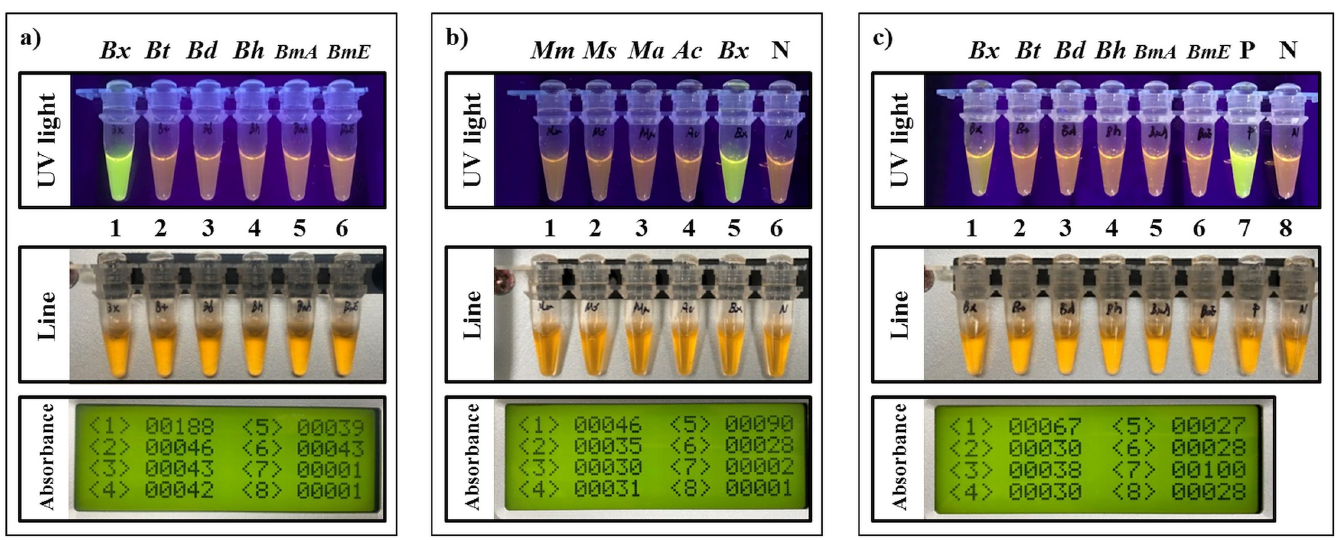
Fig 4. Three types of specificity tests of the RPA assay for B . xylophilus . a) The specificity test of the RPA assay using 6 ng of pure gDNA from B . xylophilus ( Bx ) and five Bursaphelenchus spp.: B . thailandae ( Bt ), B . doui ( Bd ), B . hylobianum ( Bh ), B . mucronatus Asia type ( BmA ), and B . mucronatus Europe type ( BmE ) which have strong genetic relationships with B . xylophilus . b) The specificity test of the RPA assay on organisms: Matsucoccus matsumurae ( Mm ), Monochamus saltuarius ( Ms ), Monochamus alternatus ( Ma ), and Anoplophora chinensis ( Ac ) which have weak genetic relationships with B . xylophilus . c) The specificity test of the RPA assay using spiked pinewood from healthy pine tree with pure gDNA from nematodes. The absorbance and UV light represent the detection results of the POID and the UV light, respectively. P and N represent the positive control using pure gDNA from B . xylophilus and the negative control using lysate from healthy pine tree extracted using the DAP buffer, respectively. The line numbering is matched with the absorbance numbering in each panel. The absorbance value of the zero point in the RPA assay was set to 50. Therefore, values of less than 50 measured by the POID are considered not specifically